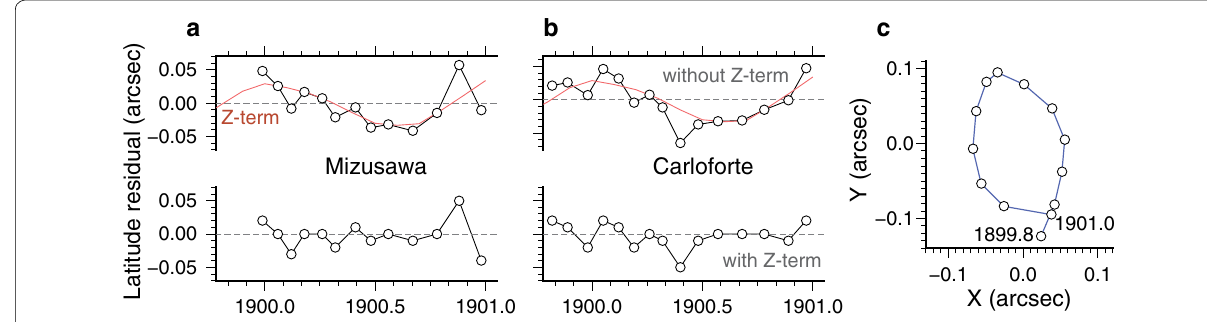
Fig. 3 Latitude variation data in 1899–1901. The residual of the latitude variation at Mizusawa ( a ) and another one of the latitude observatories at Carloforte, Italy, ( b ) before (top) and after (bottom) introducing the new longitude-independent annual term (Z-term). Red curves in a , b indicate the monthly values of the new term. The polar motion during the first year of ILS is shown in c . Re-drawn using the latitude variation residuals, the values of the Z-term, and the polar motion data in Kimura